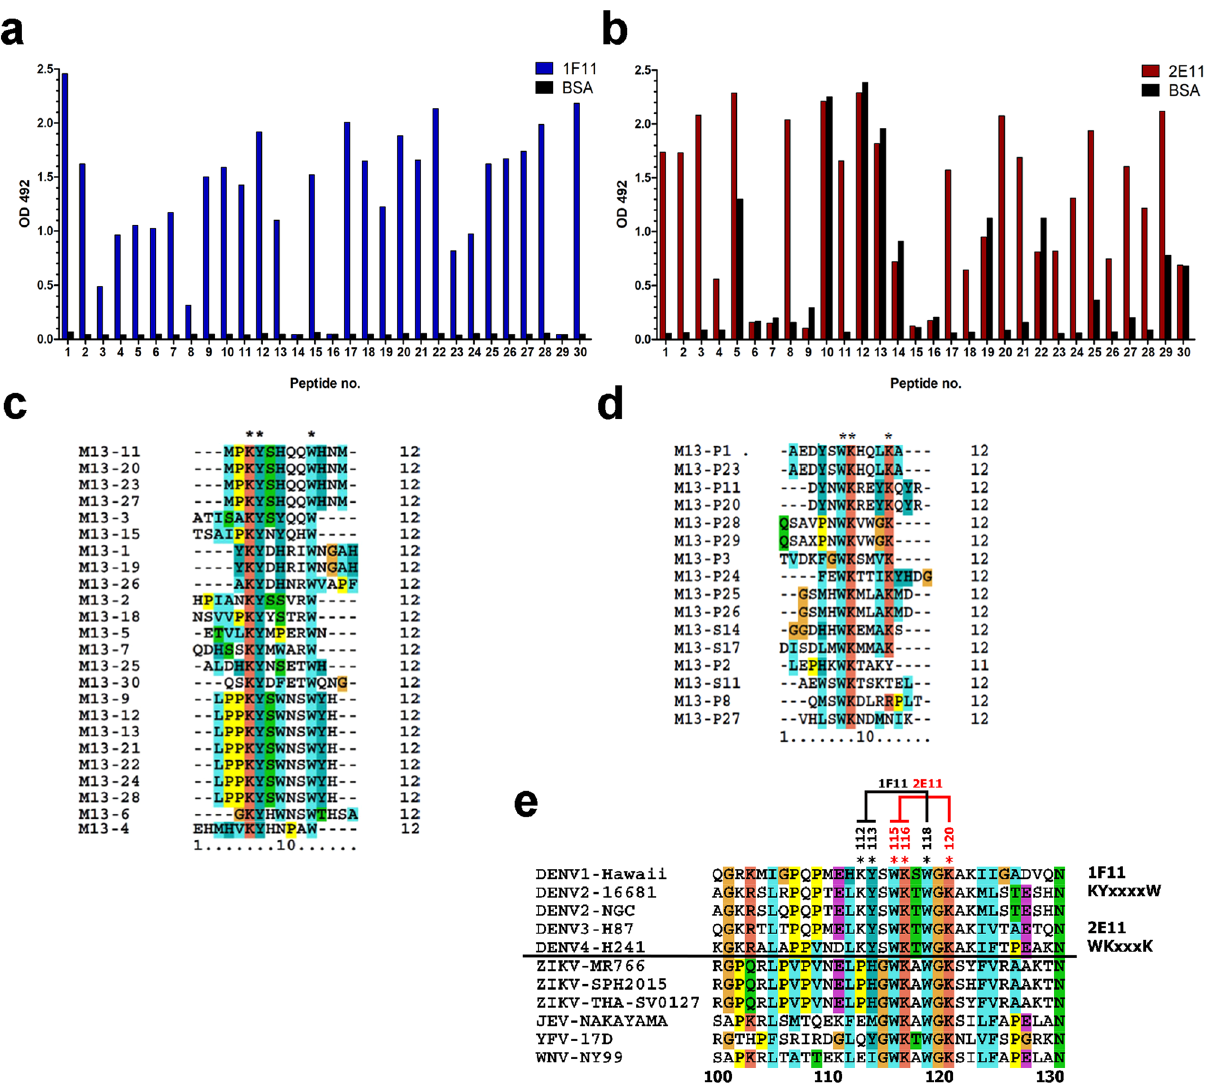
Figure 3. Mapping of anti-NS1 antibody binding epitopes by 12-mer phage surface display library. Selected phage clones obtained from phage peptide library biopanning with 1F11 ( a ) or 2E11 ( b ) were reacted with antibody-coated ELISA, followed by HRP-conjugated anti-M13 antibodies. BSA was used as a negative control protein. The 12-mer peptide sequences of twenty-four 1F11-immunopositive phage clones ( c ) and sixteen 2E11- immunopositive phages ( d ) were ascertained and aligned. Conserved residues among all phage clones of each antibody are marked by asterisks. ( e ) Alignment of NS1 aa sequences of DENV and flaviviruses from aa 99 to 129. The binding motifs of 1F11 (KYxxxxW) and 2E11 (WKxxxK) are indicated together with DENV-conserved residues matching the 1F11 motif (K112, Y113, and W118), and flavivirus-conserved residues W115, K116 and K120 matching the 2E11